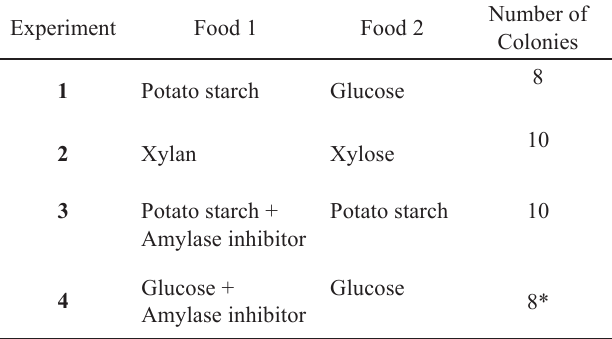
Table 1 . Summary of the molecules added to the two food items (see methods for full description of food) and the number of colonies tested in each